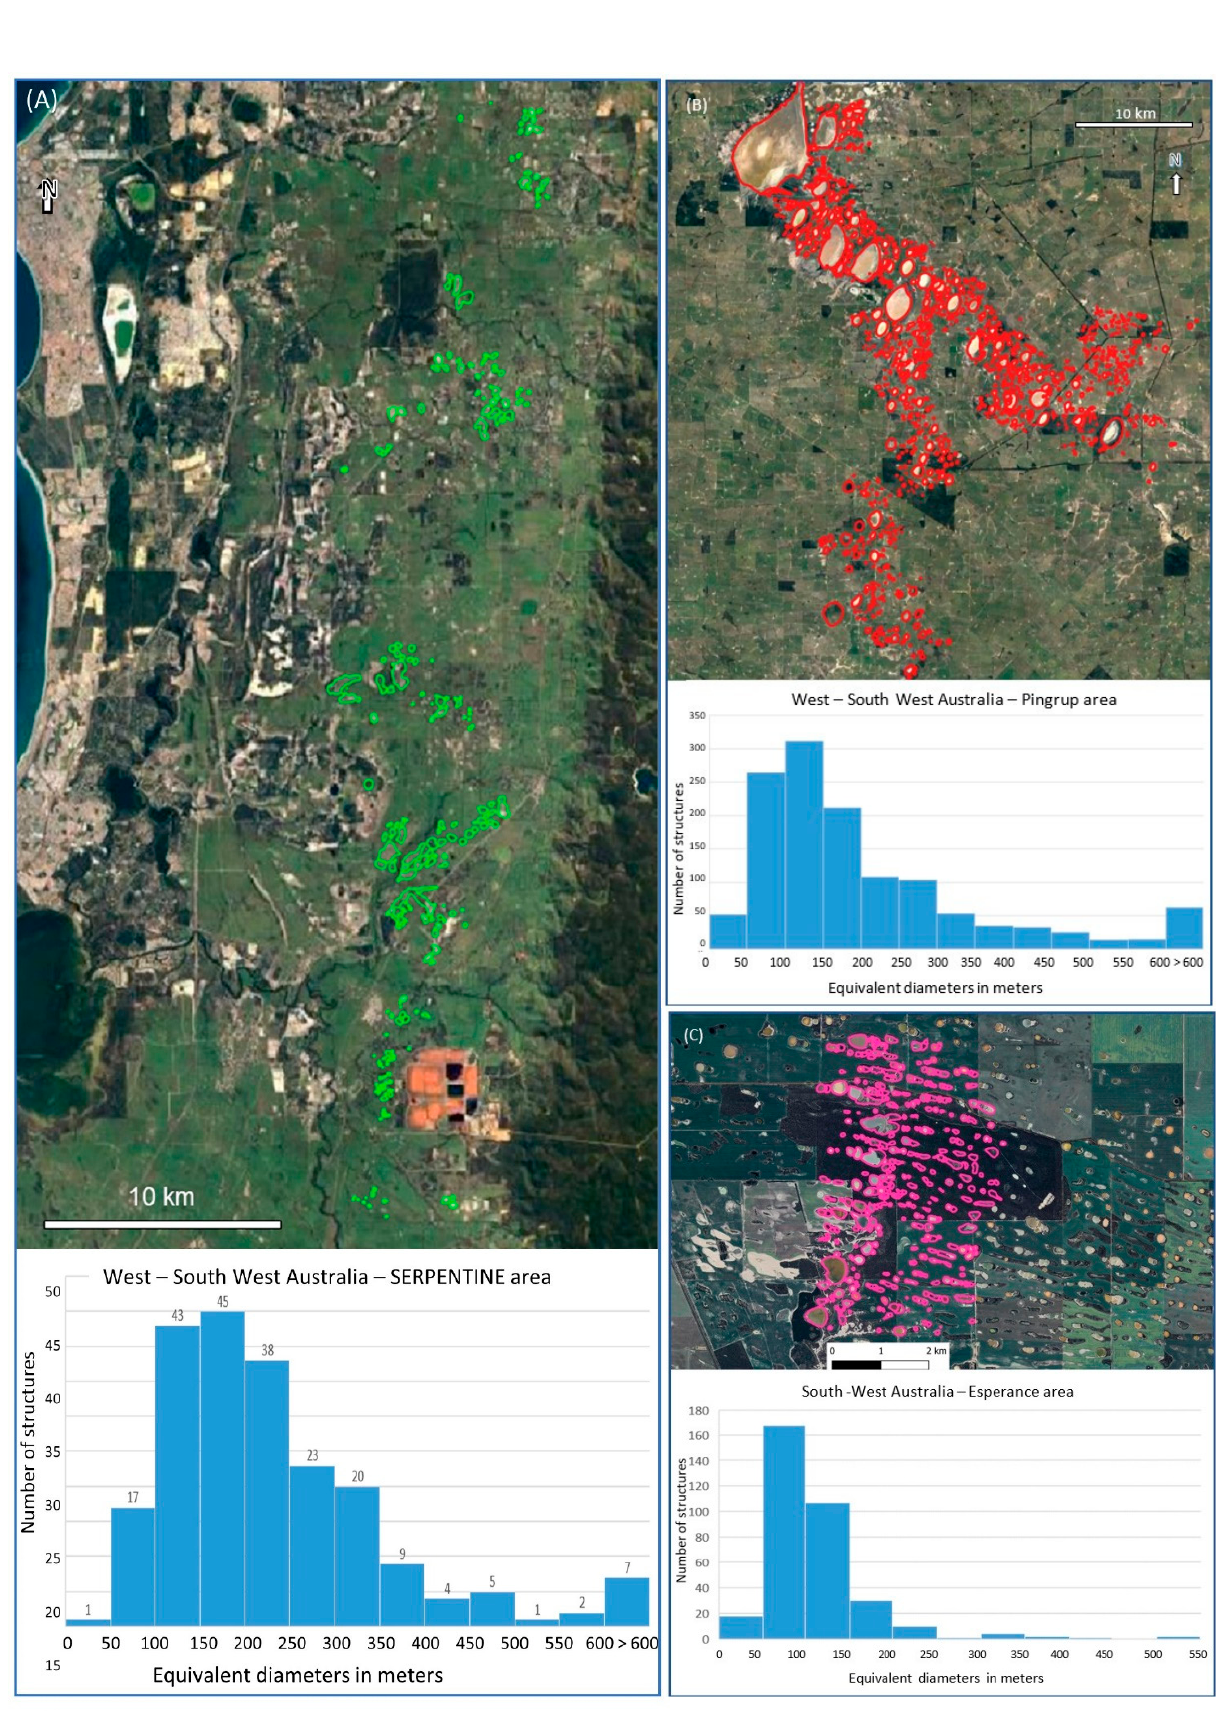
Figure 9. The mapping and the diameter equivalent statistic for fairy circles in the Perth Area, South-West Australia. ( A ) serpentine area, ( B ) Pingrup area, ( C ) Esperance